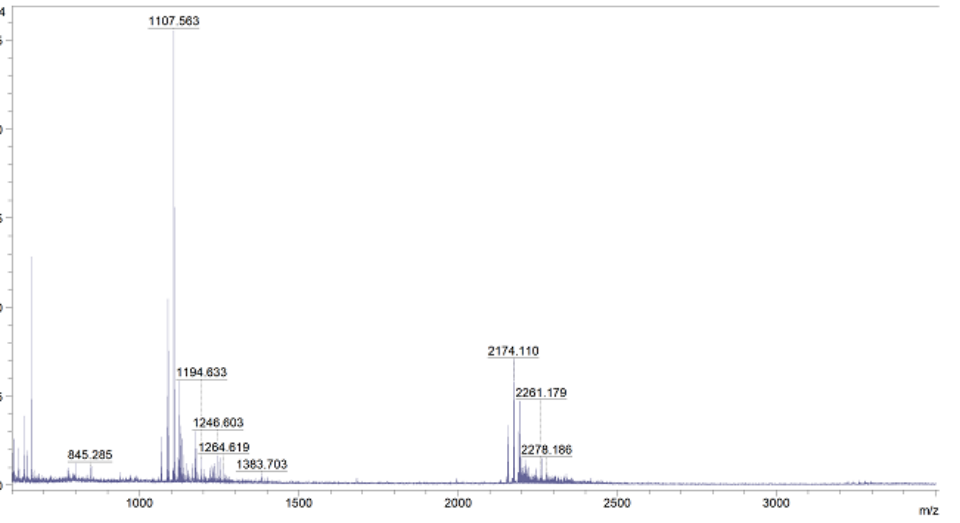
Figure 22. MS spectrum of the obtained polysaccharide–H-FFPLADDVTP-OH conjugate.